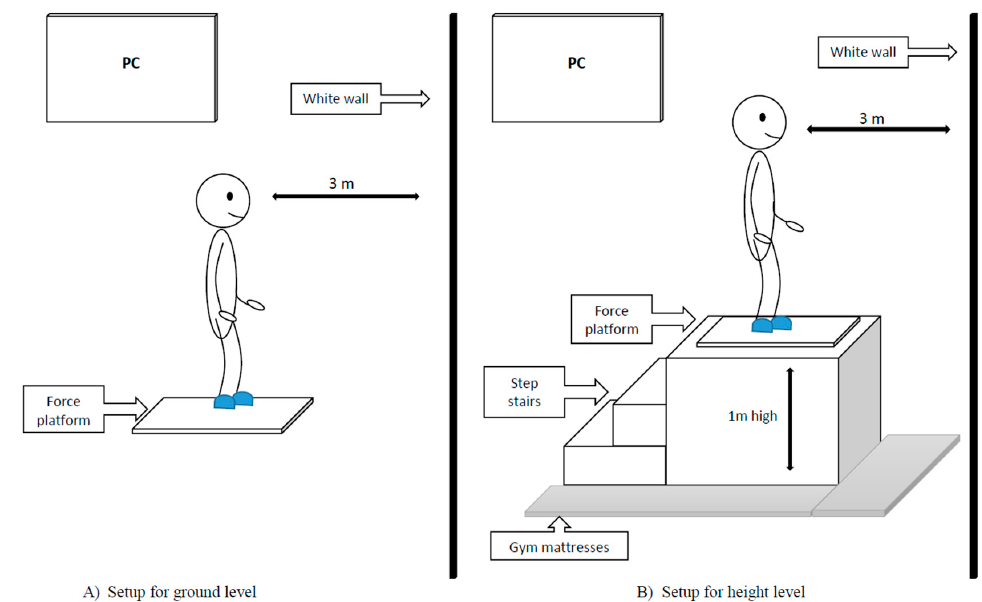
Figure 2. Experimental setup of two measuring stations at ground level ( A ) and at a height of 1 m from the ground ( B ).